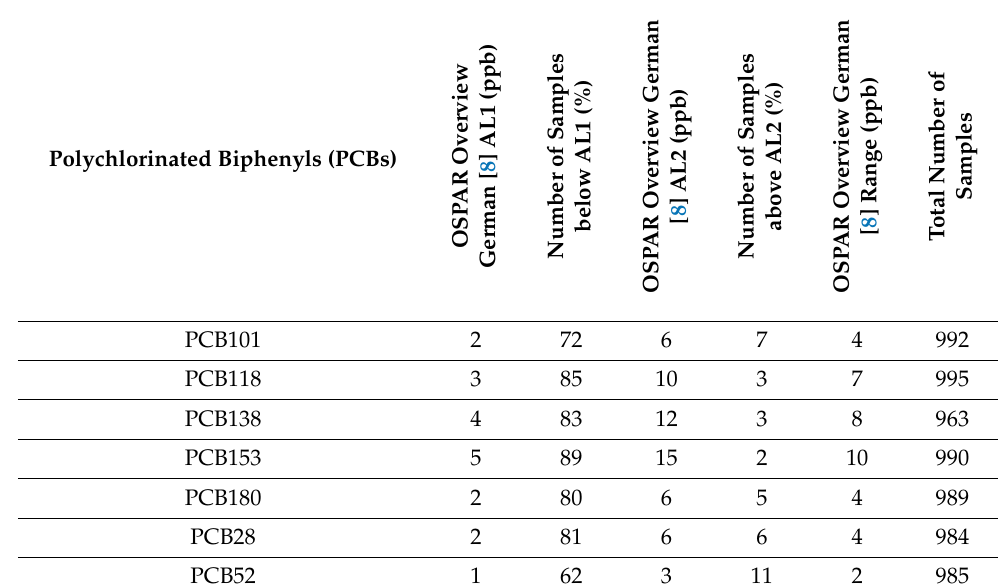
Table 15. Polychlorinated biphenyls (PCBs)—Individual PCBs (OSPAR overview German — Percentage of samples below AL1, above AL2 and